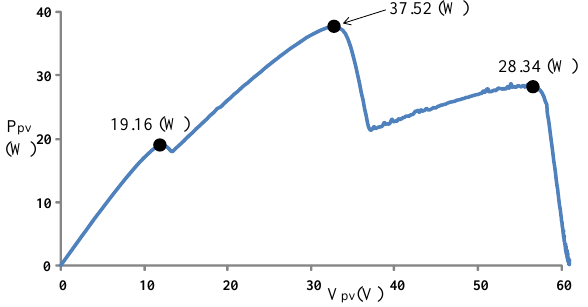
Figure 12. P–V characteristic curve of Case 2.